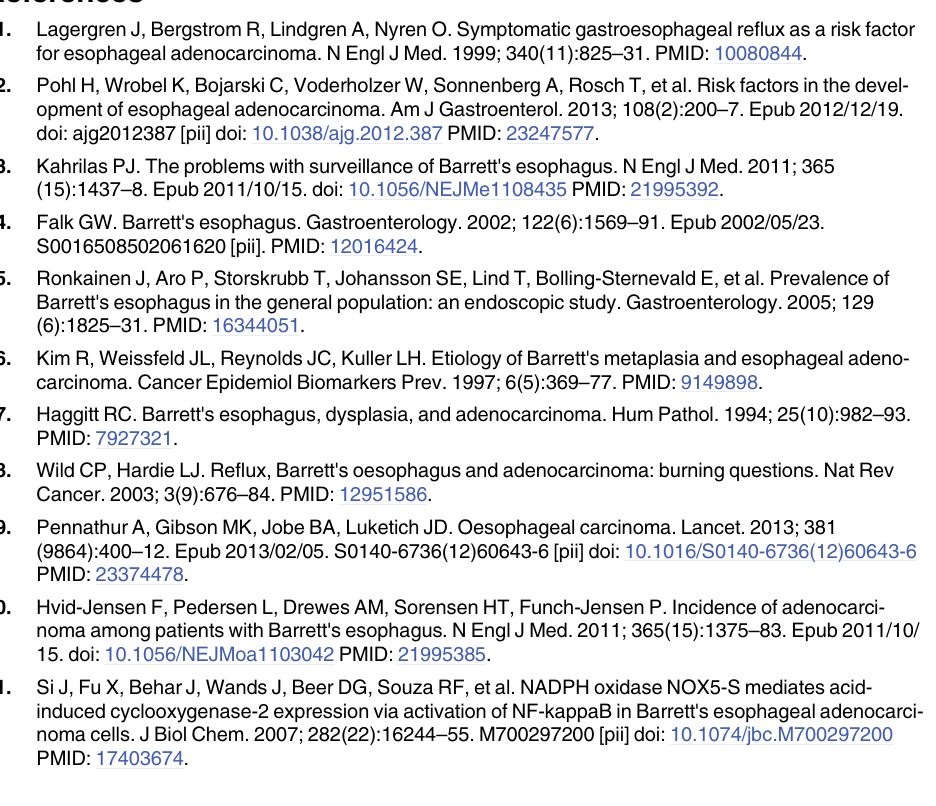
S3 Fig. Full blot images for Fig 3A. (TIF) S4 Fig. Full blot images for Fig 3C. S5 Fig. Full blot images for Fig 4A. S6 Fig. Full blot images for Fig 4B. S7 Fig. Full blot images for Fig 5A. S8 Fig. Full blot images for Fig 5B.